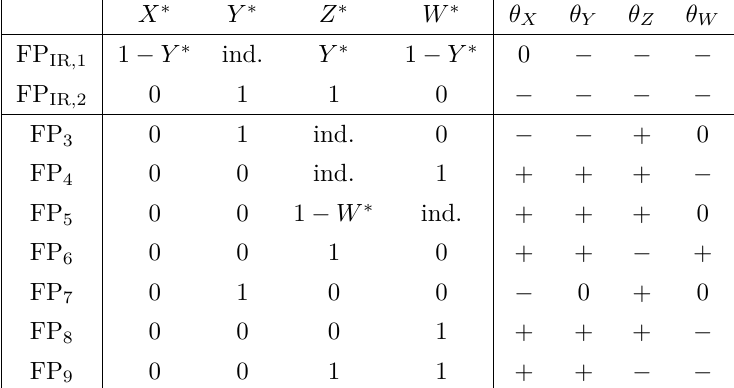
6 = 0 and all the other lepton ν 3